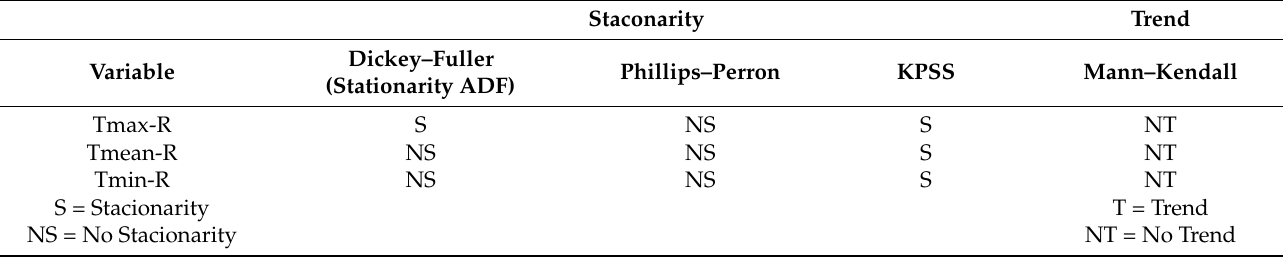
Table 7. Test for stationarity and trend for corrected temperature series.